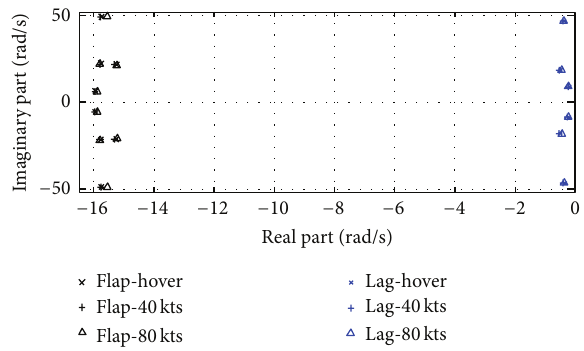
Figure 2: Loci of flapping and lead-lagging modes.